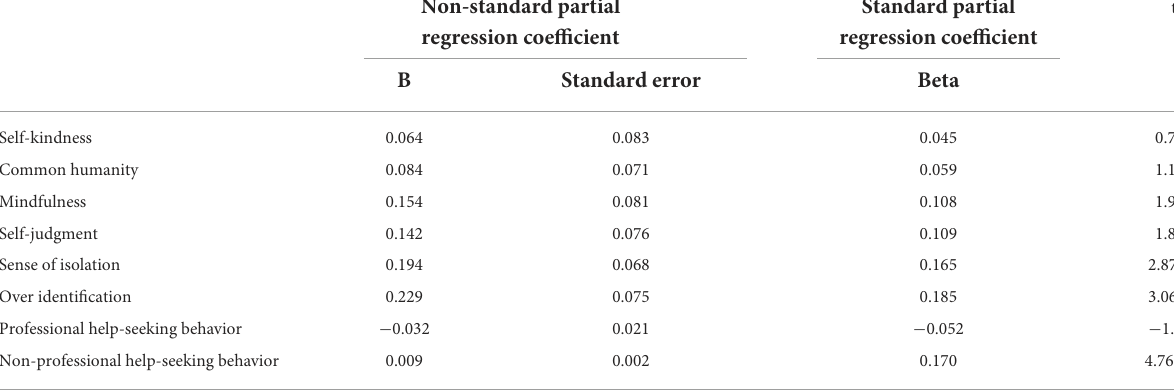
TABLE 11 Coefficient of the flourishing regression model.